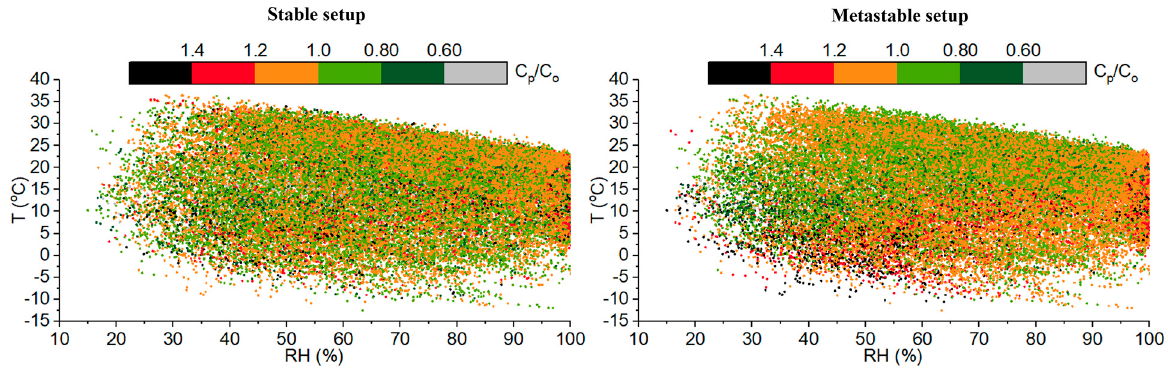
Figure 5. The ratios of C p /C o for iPM 2.5 (SO 42 − + NH 4+ + NO 3 − ) using stable and metastable model setups.